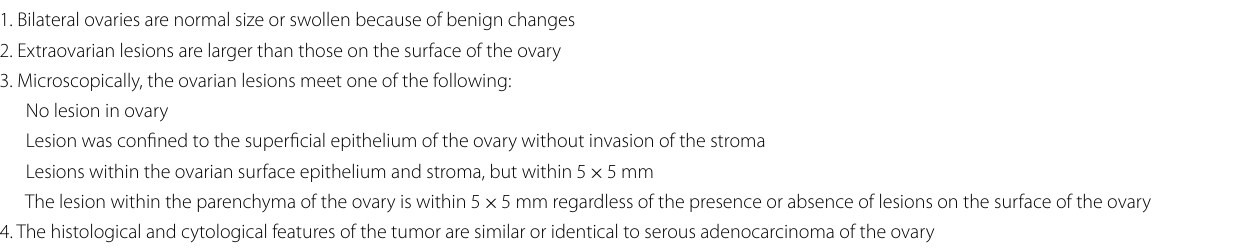
Table 2 Diagnostic criteria for primary peritoneal cancer